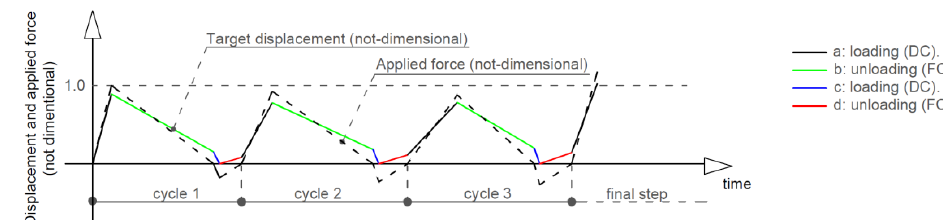
Figure 12. Multistep experimental procedure for the joint sample “I”.